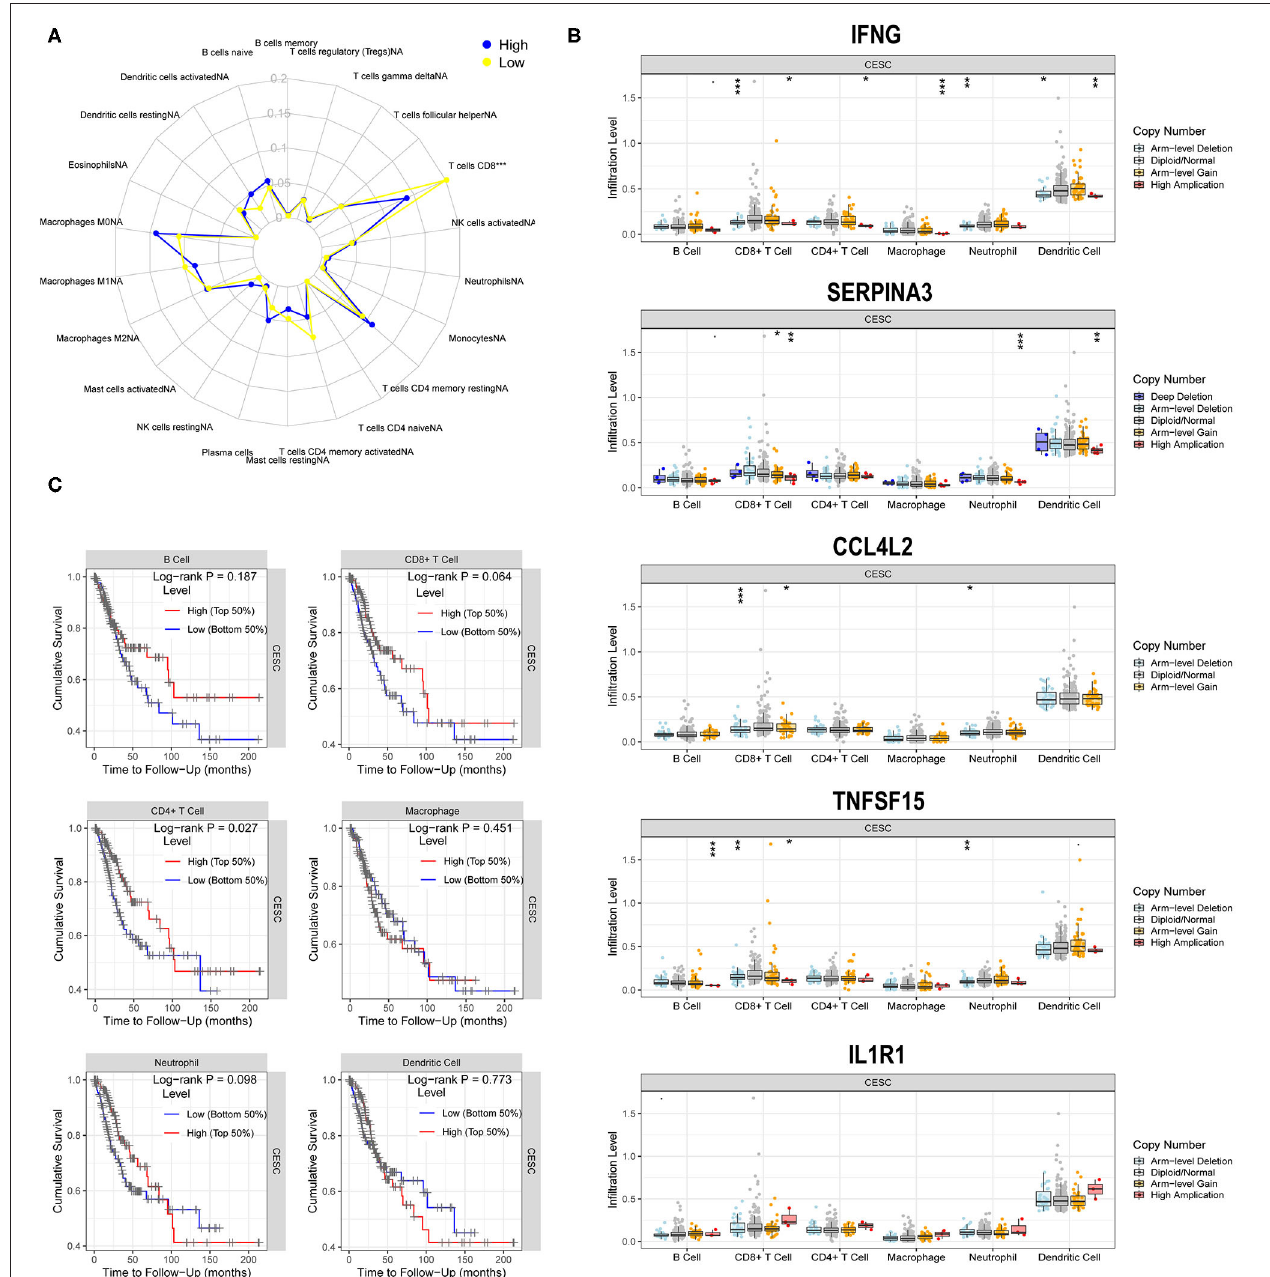
FIGURE 8 | Correlations of five hub genes with immune cell infiltration. (A) Radar plot showing differences in immune cell infiltration between the high- and low-risk groups. *, P < 0.05; **, P < 0.01; ***, P < 0.001. (B) Box plots presenting the distributions of six immune cells in different copy number status of five hub genes in CG. (C) Kaplan–Meier analysis revealing low infiltration levels of CD4 + T cell associated with poor prognosis in CESC ( P < 0.05).